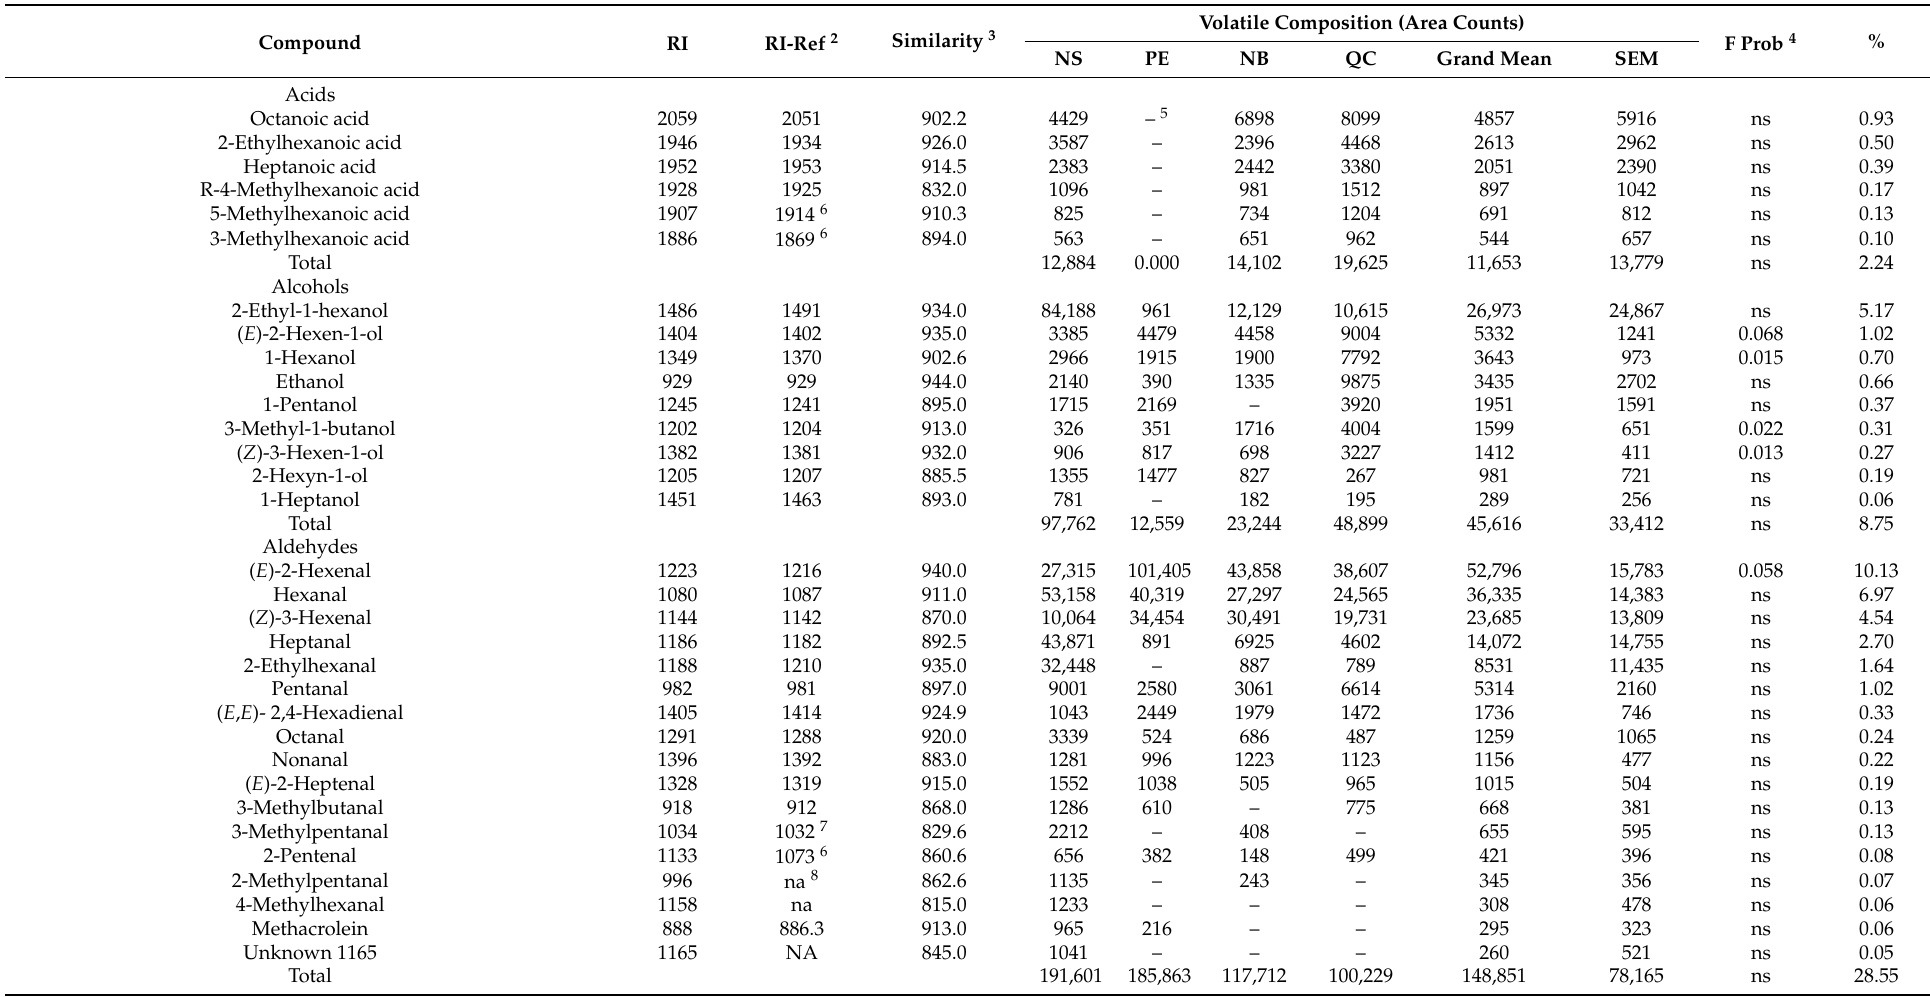
Table 2. Headspace volatile composition of wild lowbush blueberry fruit from the provinces of Nova Scotia (NS), Prince Edward Island (PE), New Brunswick (NB) and Quebec (QC) determined by 2-dimensional gas chromatography–time of flight–mass spectrometry (GCxGC-TOF-MS) 1 .